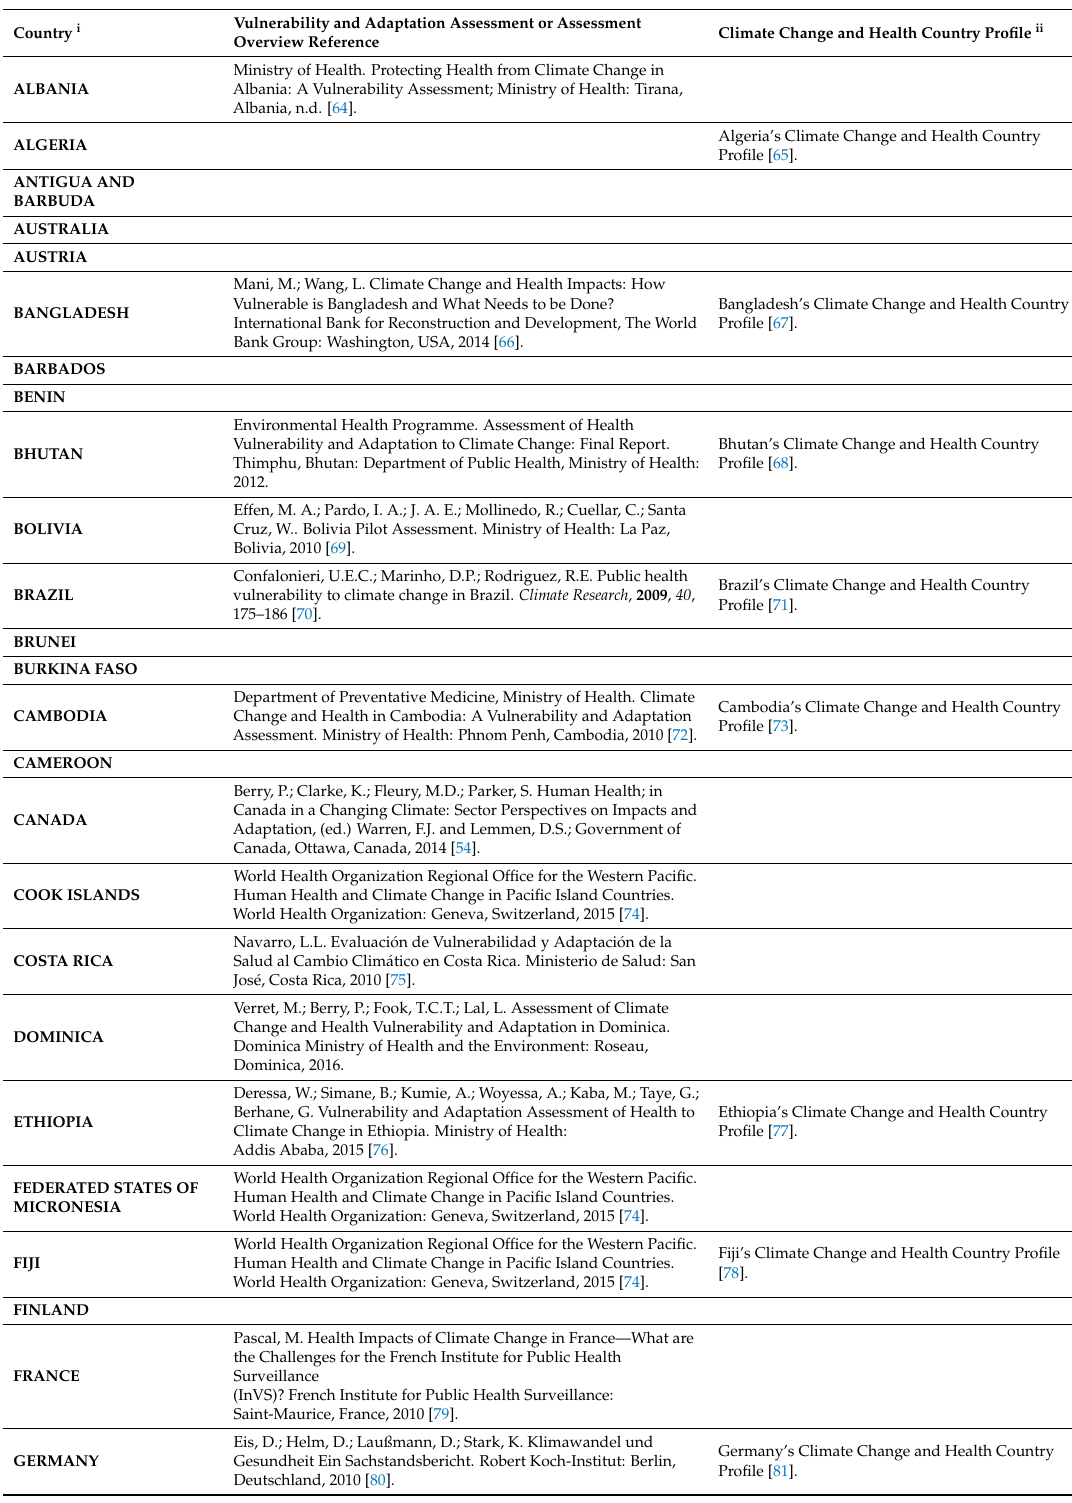
Table A1. Completed National-Level Climate Change and Health Vulnerability and Adaptation Assessments